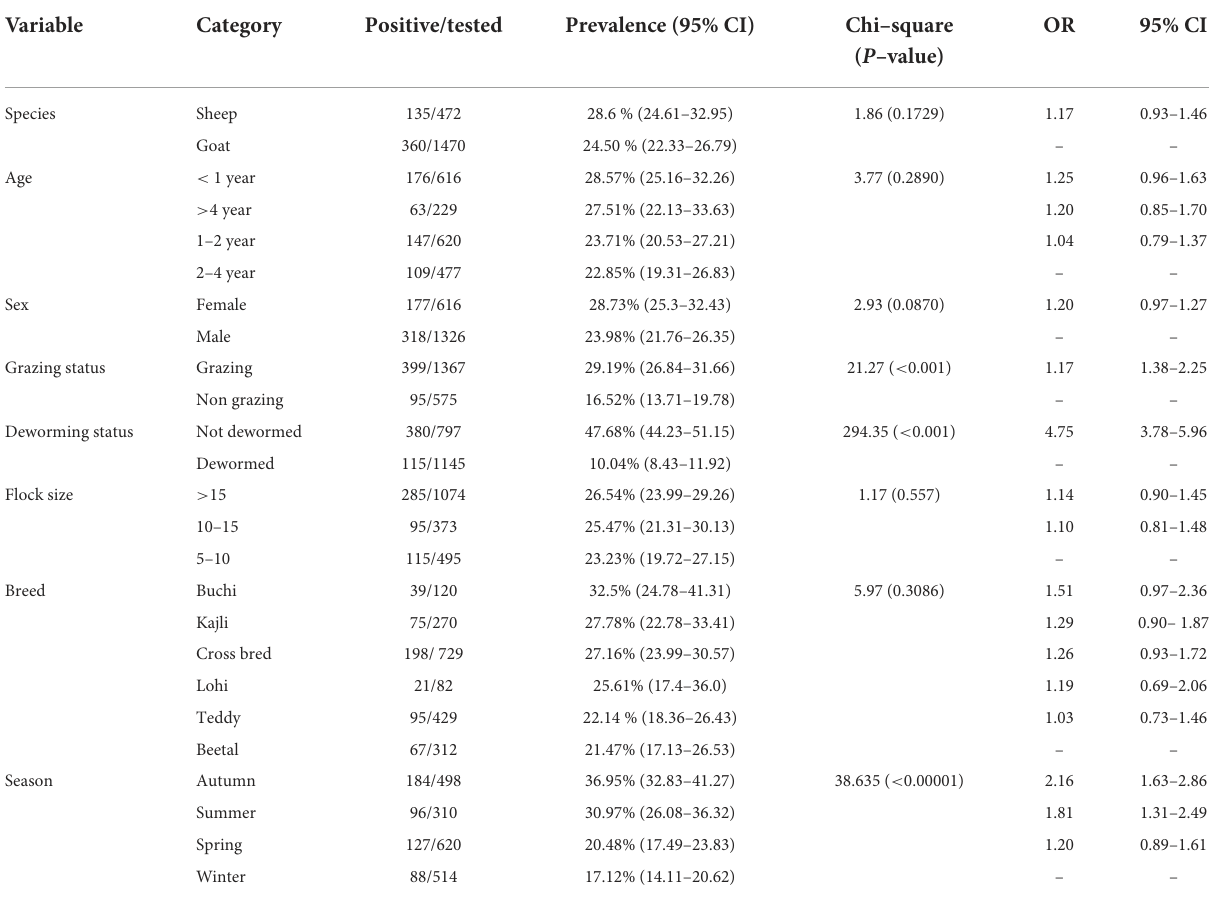
TABLE 1 Prevalence of Paramphistomum epiclitum in small ruminants.